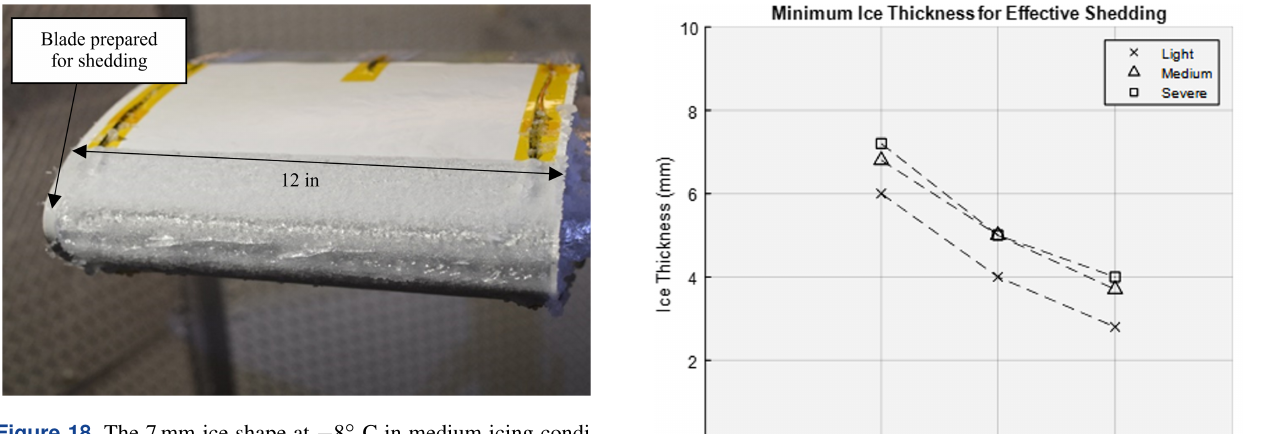
Figure 18. The 7mm ice shape at − 8 ◦ C in medium icing condi- tions.